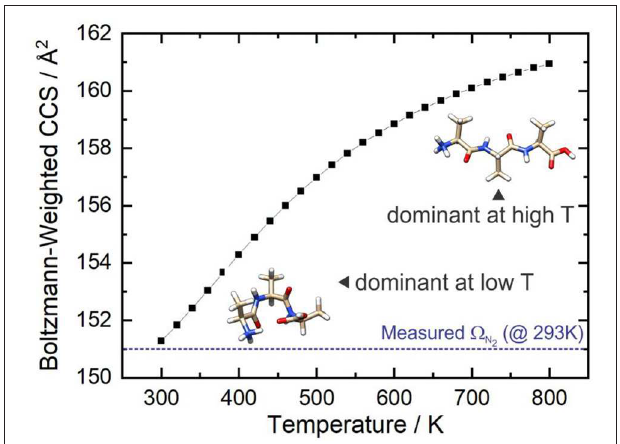
FIGURE 10 | The Boltzmann-weighted CCS of [AAA temperature at P 1 atm. The dashed blue line shows the = orientationally-averaged CCS, (cid:127) ave , measured in N 2 at room temperature (T 293K) ( Bush et al., ≈